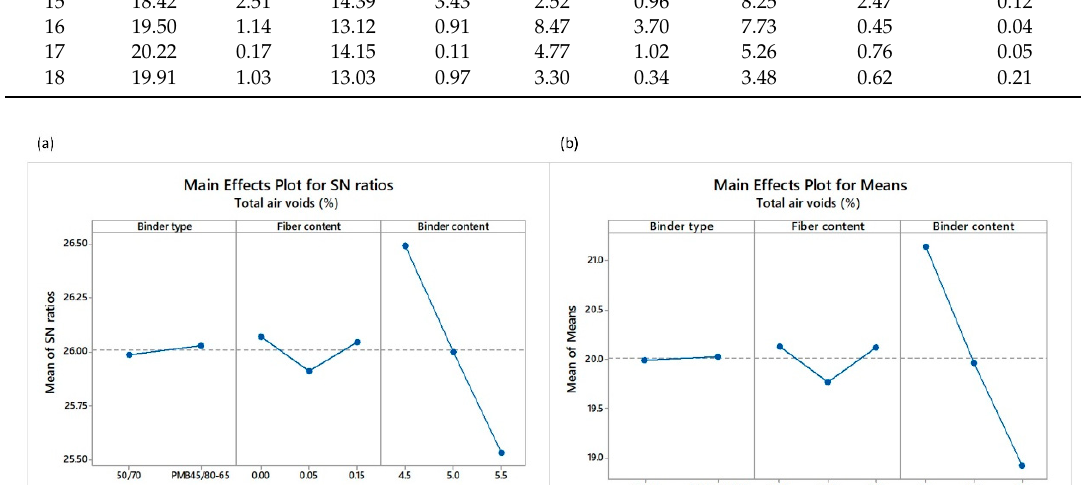
Figure 4. Main e ff ects plots of ( a ) SNR and ( b ) means of the total air voids T AV Figure 4. Main effects plots of ( a ) SNR and ( b ) means of the total air voids 𝑇 (cid:3002)(cid:3023) .